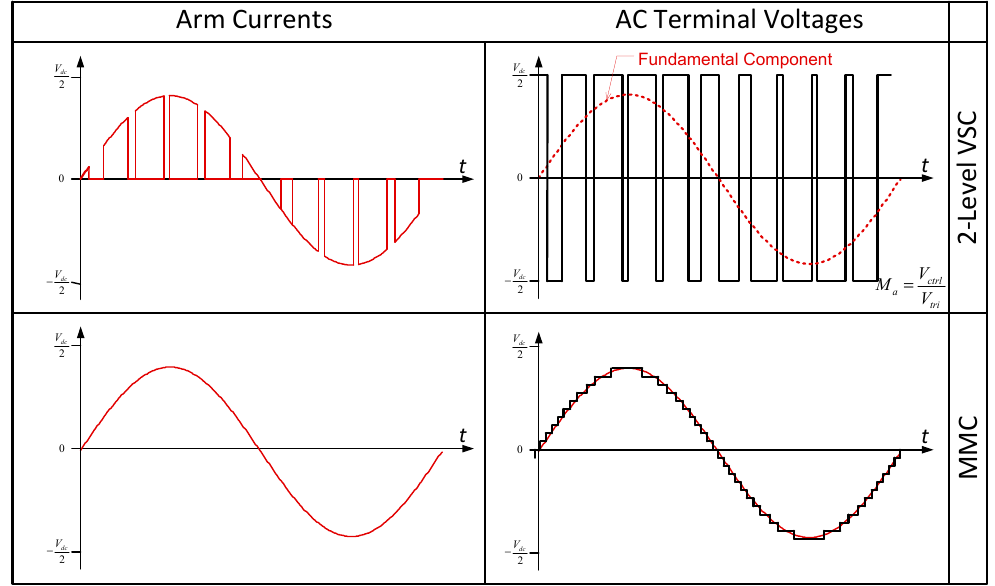
Figure 25. Arm switching pattern for a given output voltage.